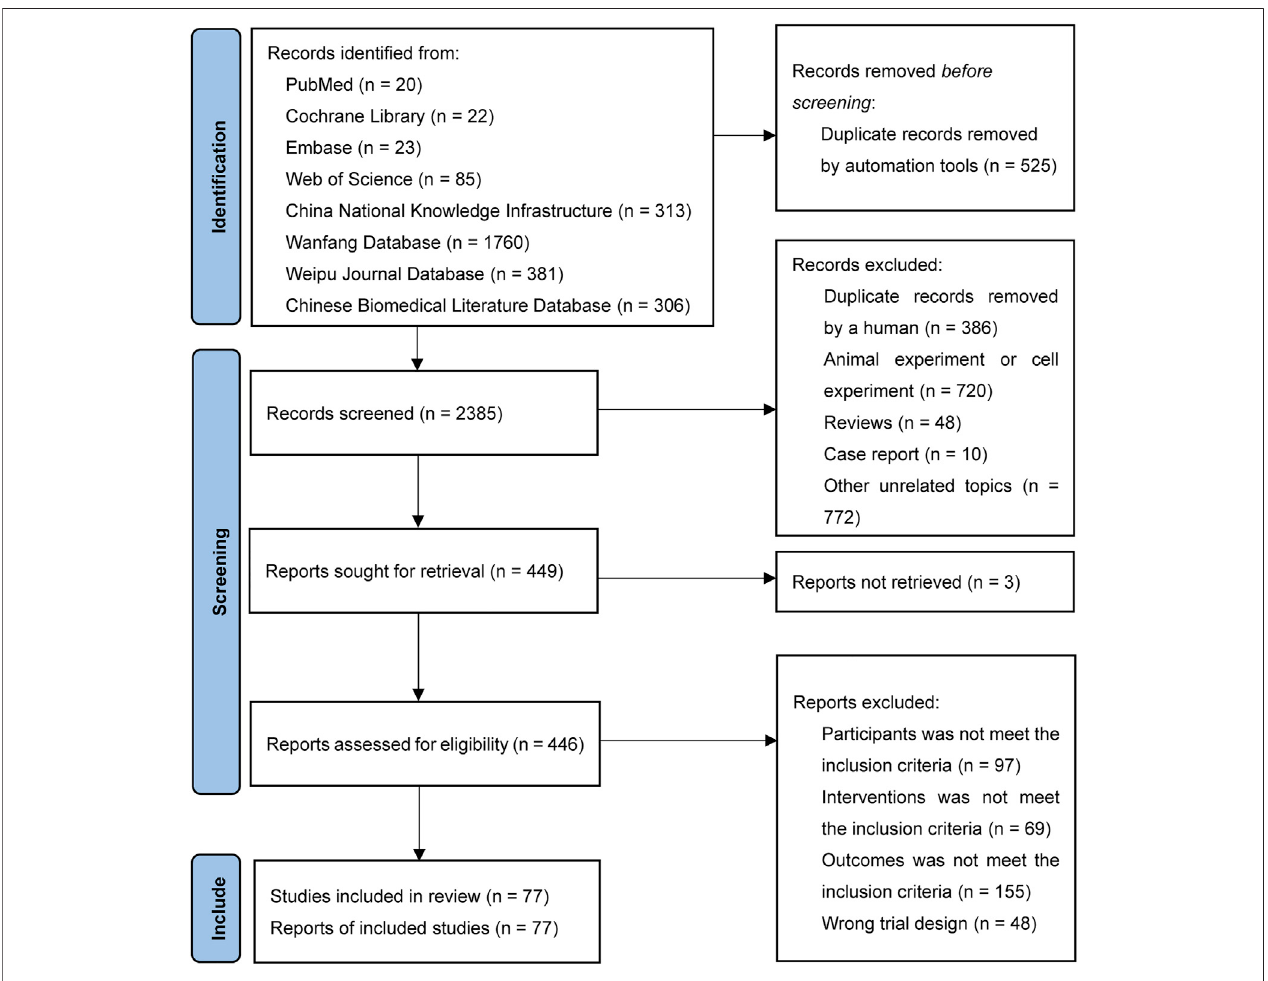
FIGURE 1 | Flow chart for literature